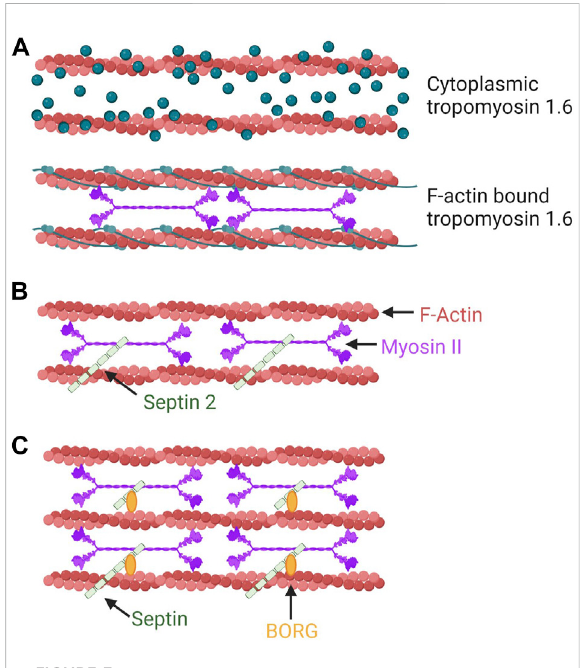
FIGURE 3 Tropomyosins, septins, andtheBORGproteins canmodulate the NMII activity within discrete populations of actin fi laments. (A) TpmscanmodulatetheactivityofNMIIonF-actin.Inthisexample, the association of Tpm 1.6 with actin stress fi bers increases NMIIactivity.Thismechanism aidsinpressure-based3Dmigration mechanisms such as the nuclear piston. (B) SEPT2 can promote actomyosin contractility through a direct interaction with NMII on F-actin. (C) BORG (binder of Rho GTPases) proteins are effectors of the small GTPase Cdc42 that bind and regulate septins to modulate intracellular force production by